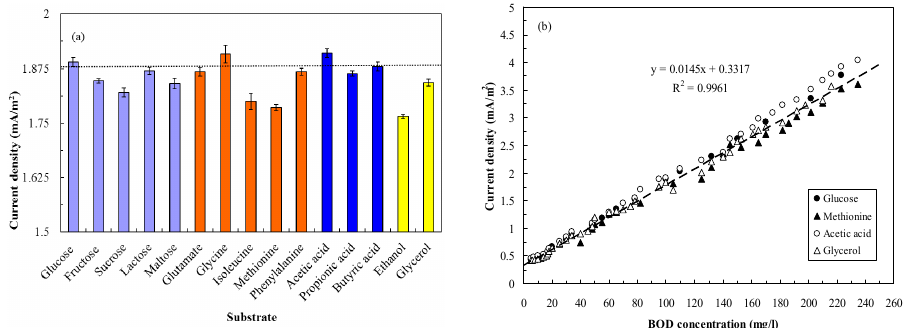
Figure 3. ( a ) Effects of different substrates on the MFC performance (substrate concentration: 100 mg/L as BOD 5 ; LRT: 4 h; GRT: 6 min); ( b ) Relationship between BOD 5 concentration and voltage output of